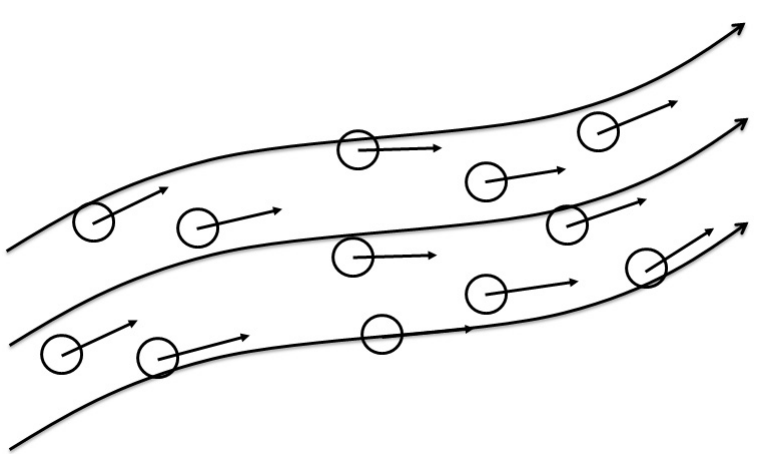
Figure 3. The behavior of fluid can be understood as the ensemble of fluid